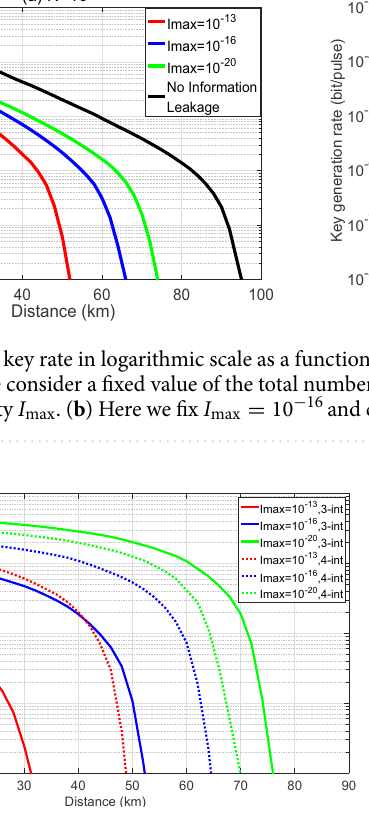
/ℓ ′ I Figure 7. The ratio ( ℓ ′ I ) between the secret key rates in logarithmic scale with and without max > 0 max = 0 10 14 , of transmitted pulses in the two information leakage as a function of the distance for a fixed number, N = protocols (3-int and 4-int represent the three-intensity decoy state MDI-QKD protocol and the four-intensity decoy-state MDI protocol that we consider,